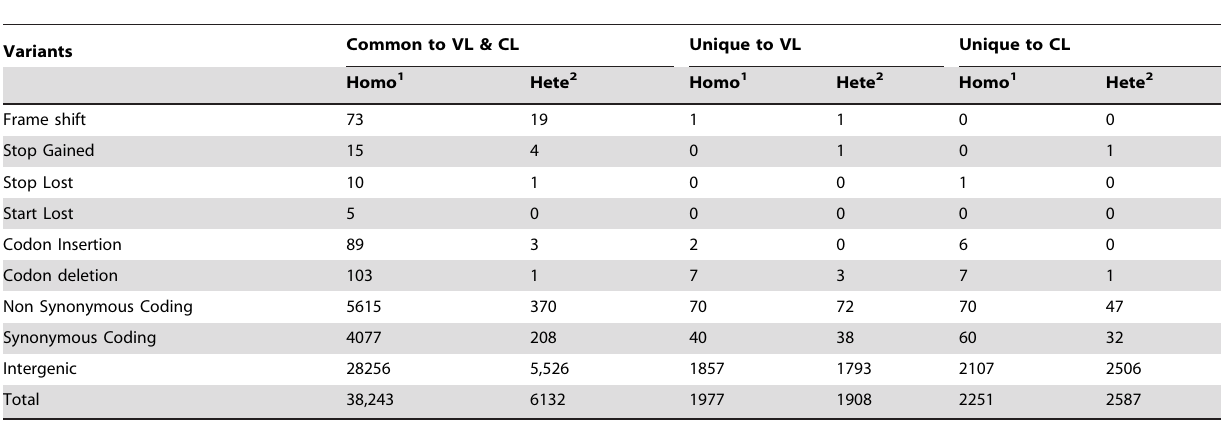
Table 2. Effects of SNPs and Indels on the genomes/proteomes of Sri Lanka L. donovani isolates.